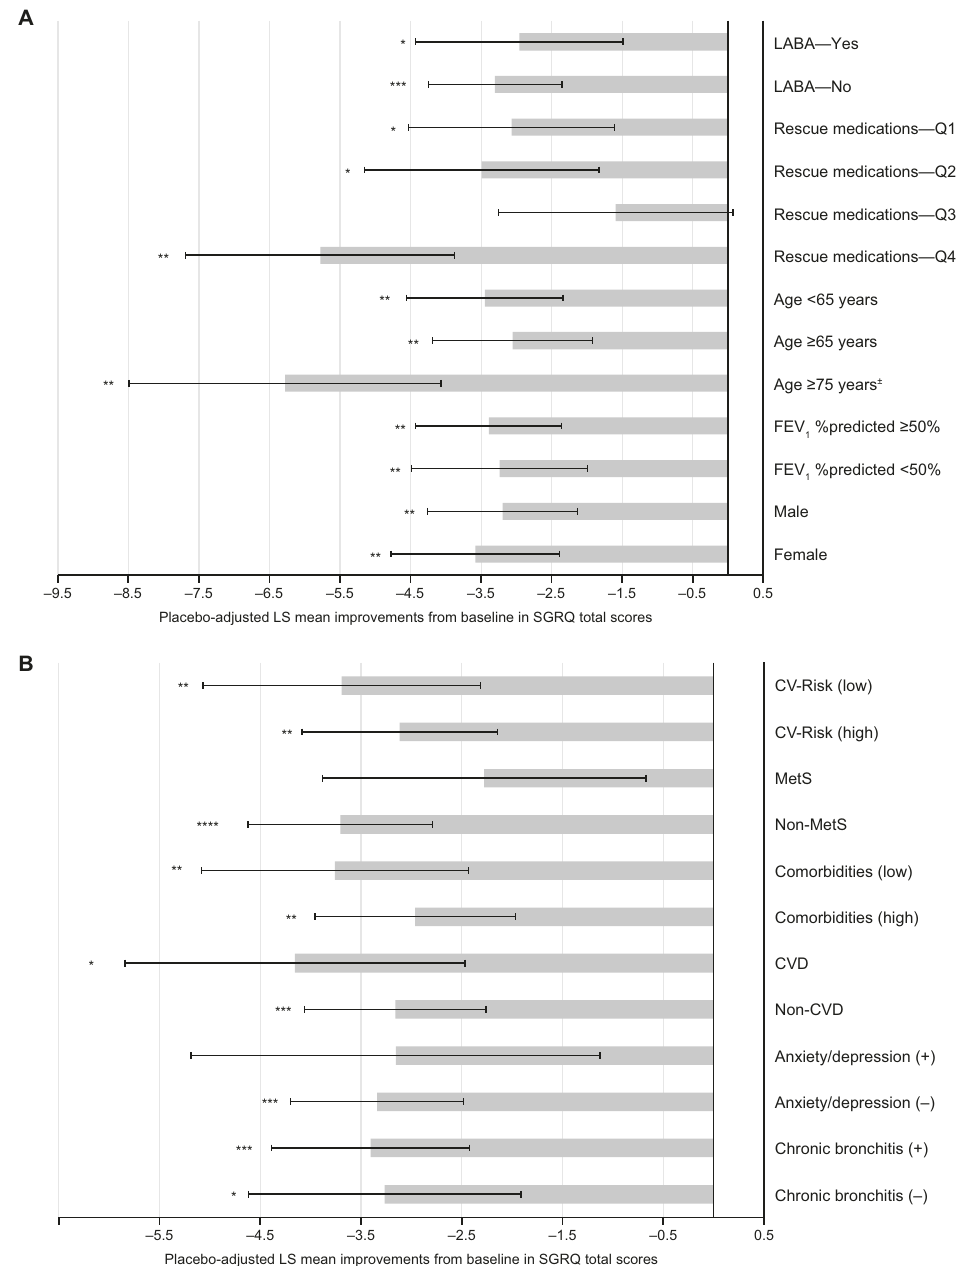
Fig. 3 Placebo-adjusted improvements from baseline in SGRQ total scores. Analysis by A baseline demographics and disease severity, and B comorbidities and chronic bronchitis at baseline, at 12 weeks. * p < 0.05; ** p < 0.01; *** p < 0.001; **** p < 0.0001 versus placebo, analyzed by ANCOVA. Only placebo and GLY 25 µg dose from the GOLDEN 3 and 4 studies are shown. ± Subset of the ≥ 65 years group. CV cardiovascular, CVD cardiovascular disease, FEV 1 forced expiratory volume in 1 s, GLY nebulized glycopyrrolate, LABA long-acting β 2 -agonist, LS least squares, MetS metabolic syndrome, Q quarter, SGRQ St. George ’ s Respiratory